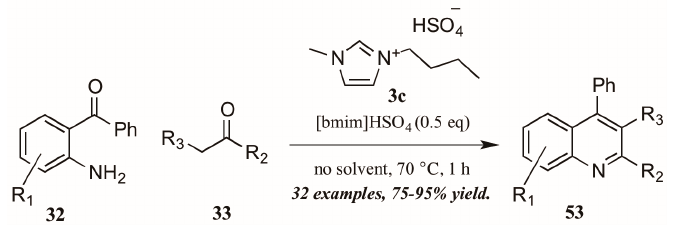
Figure 25. Ionic liquid acid-catalyzed Friedländer quinoline synthesis.